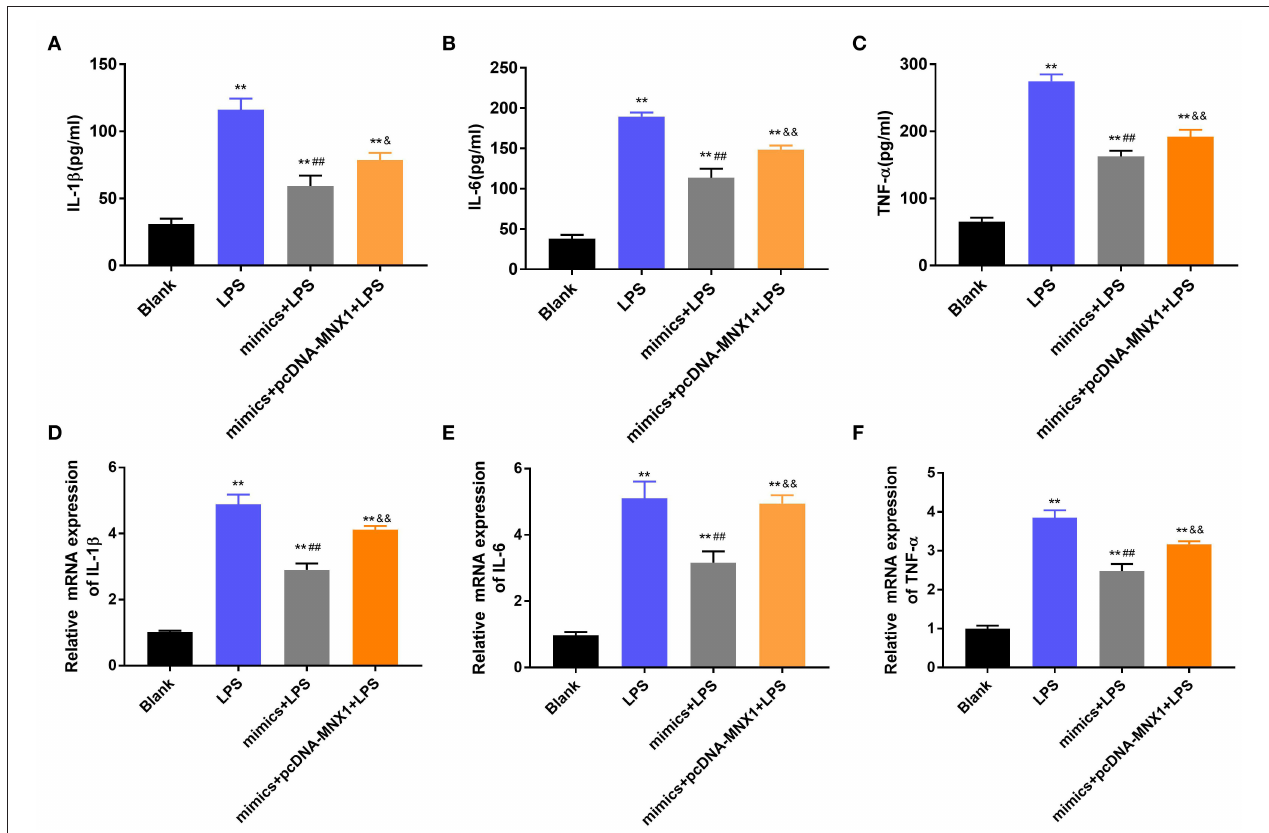
FIGURE 5 | MNX1 eliminated the functions of miR-141-3p in inflammatory response of IEC-6 cells. After LPS irritation and the correlative vectors transfection, the concentrations of (A) IL-1 β , (B) IL-6, and (C) TNF- α were examined via ELISA; the mRNA expression of (D) IL-1 β , (E) IL-6, and (F) TNF- α were tested via RT-qPCR. ** P < 0.01 in comparison with the Blank group; ## P < 0.01 in comparison with the LPS group; & P < 0.05, && P < 0.01 in comparison with mimics +